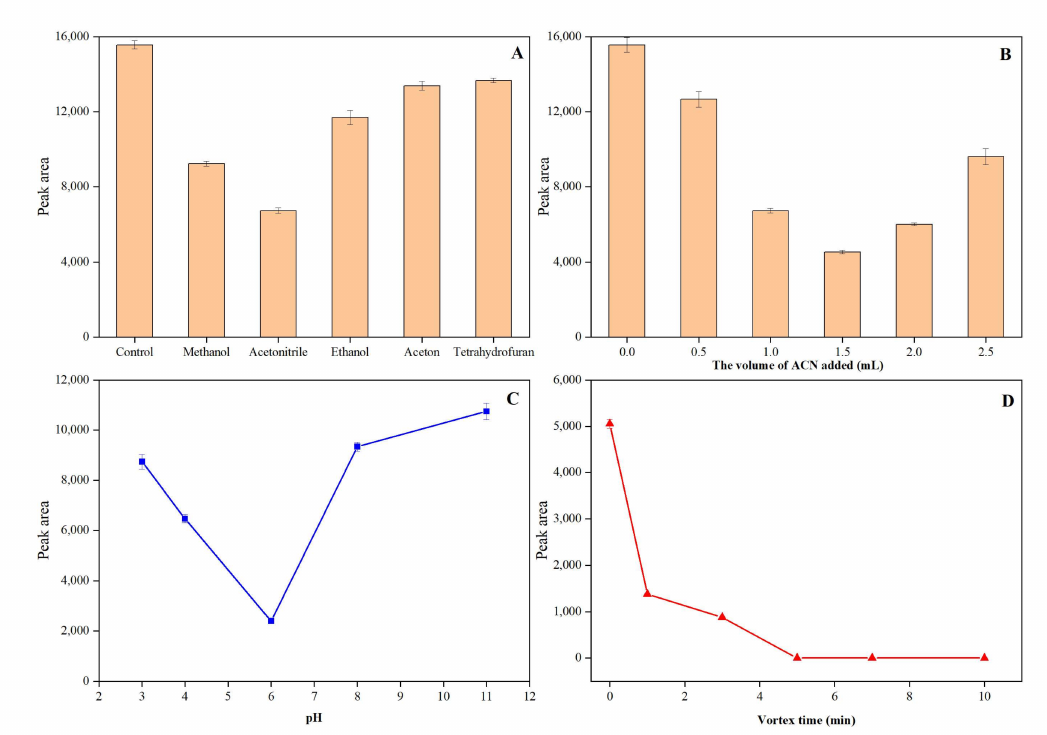
Figure 3. Effects of different types ( A ) and volumes ( B ) of organic cosolvent, pH ( C ) and vortex time ( D ) on extraction